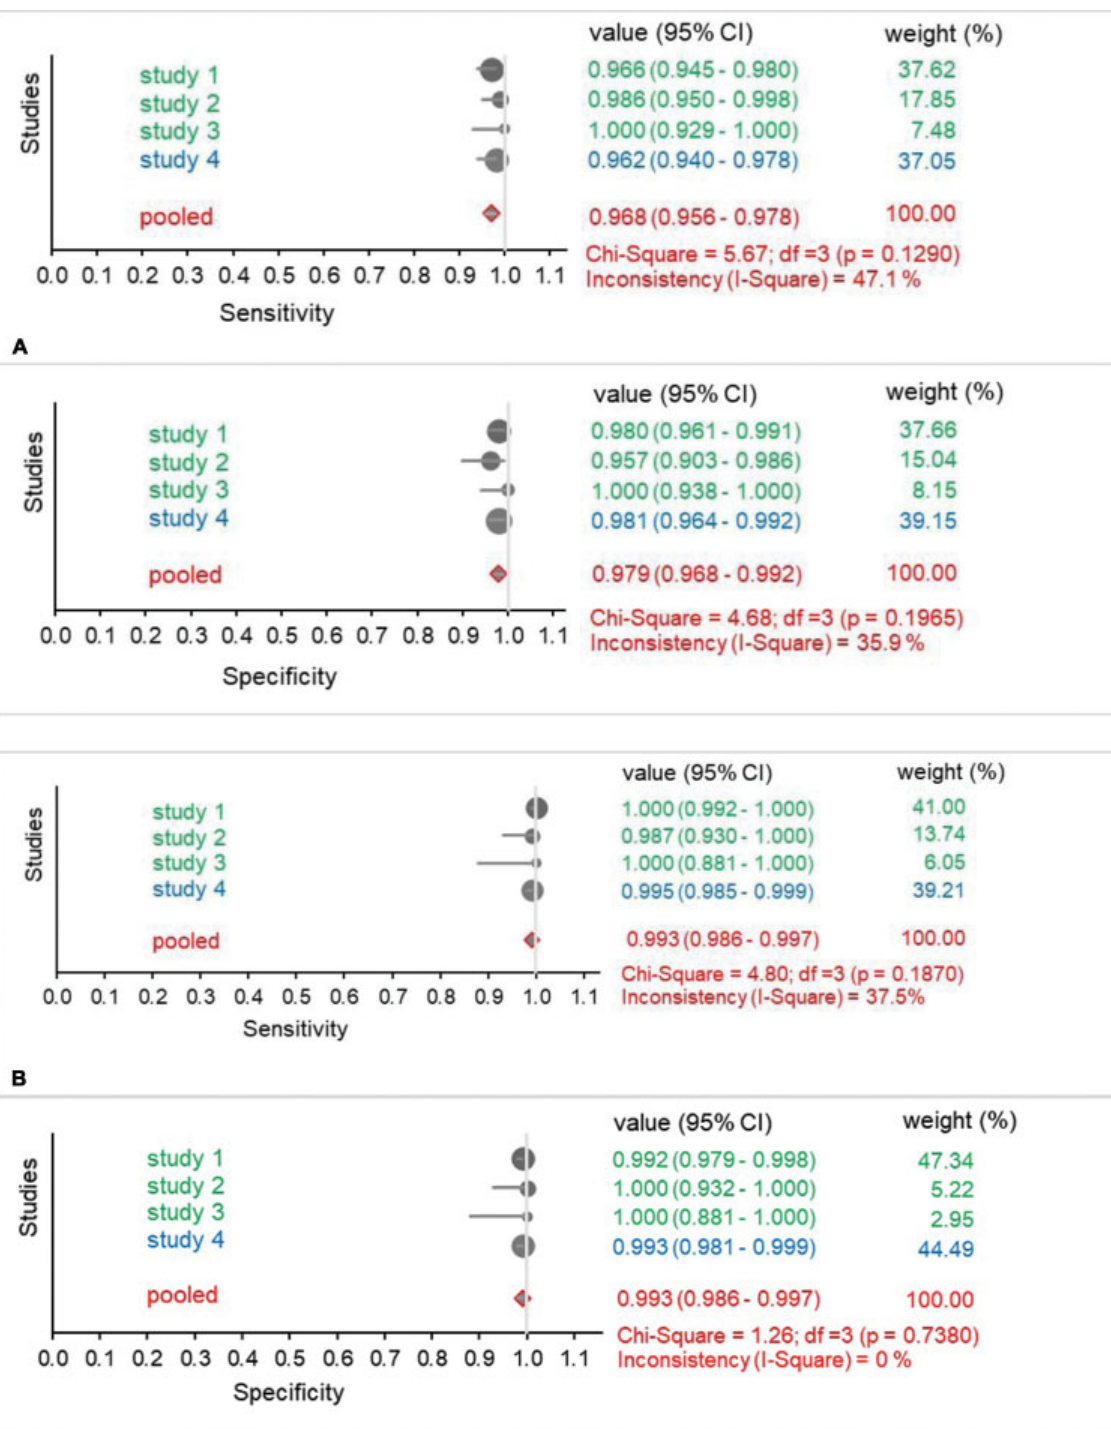
Fig. 2 Forest plot showing sensitivity (upper panel) and speci fi city (lower panel) analysis results for studies with DXI ( ► Figure 2A ), DTI ( ► Figure 2B ), rivaroxaban ( ► Figure 2C ), and apixaban ( ► Figure 2D ) using the prototype (green) and commercial (blue) test strips. Pooled data are shown in red. Values are presented with 95% CI. Size of the circles represents the weight of the studies. P-values were determined using the Chi-squared test. Inconsistency/Heterogeneity of studies is shown in %. (A) Forest plots DXI, sensitivity (upper panel), speci fi city (lower panel). (B) Forest plots DTI, sensitivity (upper panel), speci fi city (lower panel). (C) Forest plots rivaroxaban, sensitivity (upper panel), speci fi city (lower panel). (D) Forest plots apixaban, sensitivity (upper panel), speci fi city (lower panel).